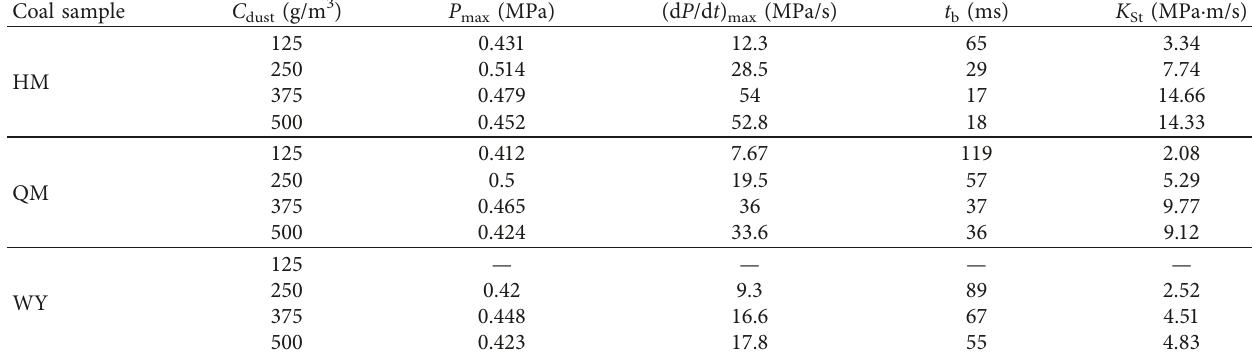
Table 3: Explosibility parameters of coal dust.